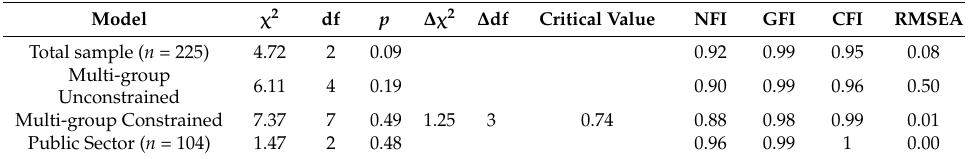
Table 3. Summary of Path